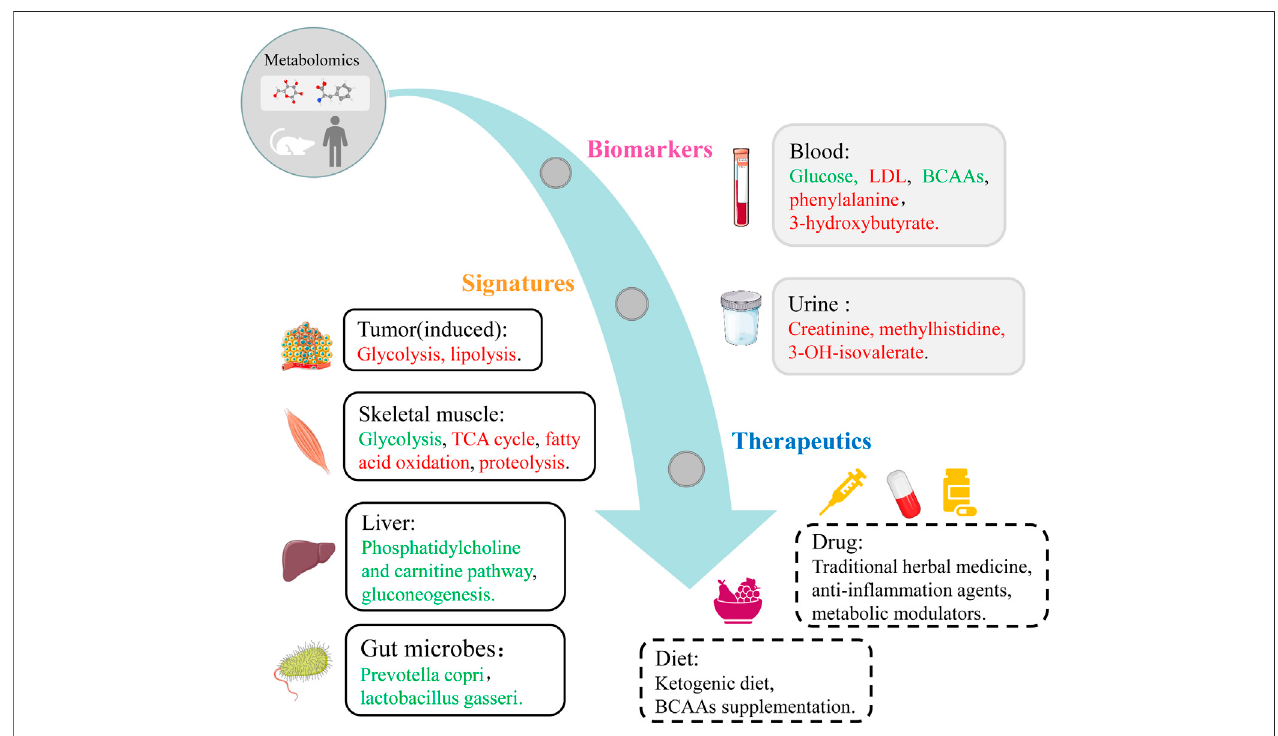
FIGURE 2 | Metabolomics applications covering biomarkers, signatures and therapeutic targets in CC. Red, upregulated metabolites and pathways in CC group. Green, downregulated metabolites, microbes and pathways in CC group.